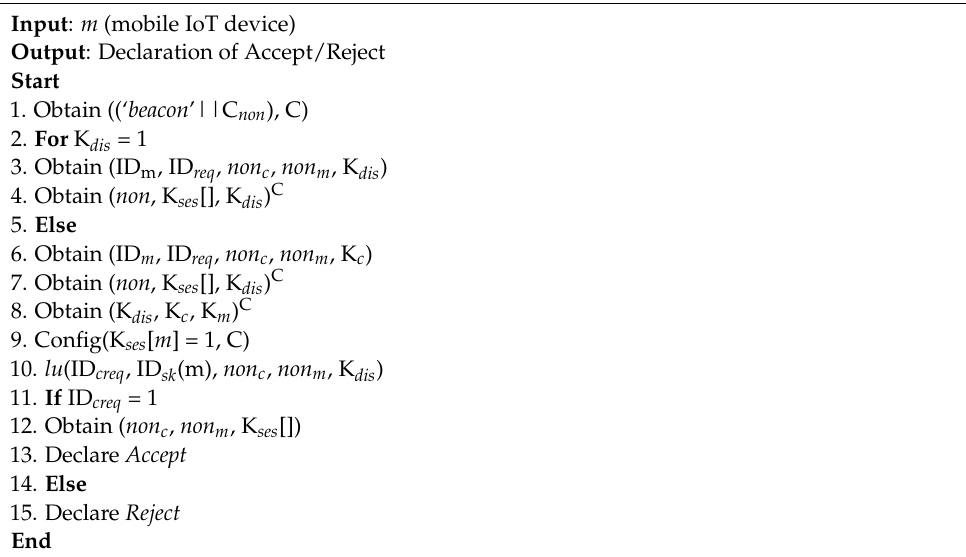
Algorithm 1 Permission Rights for Mobile IoT